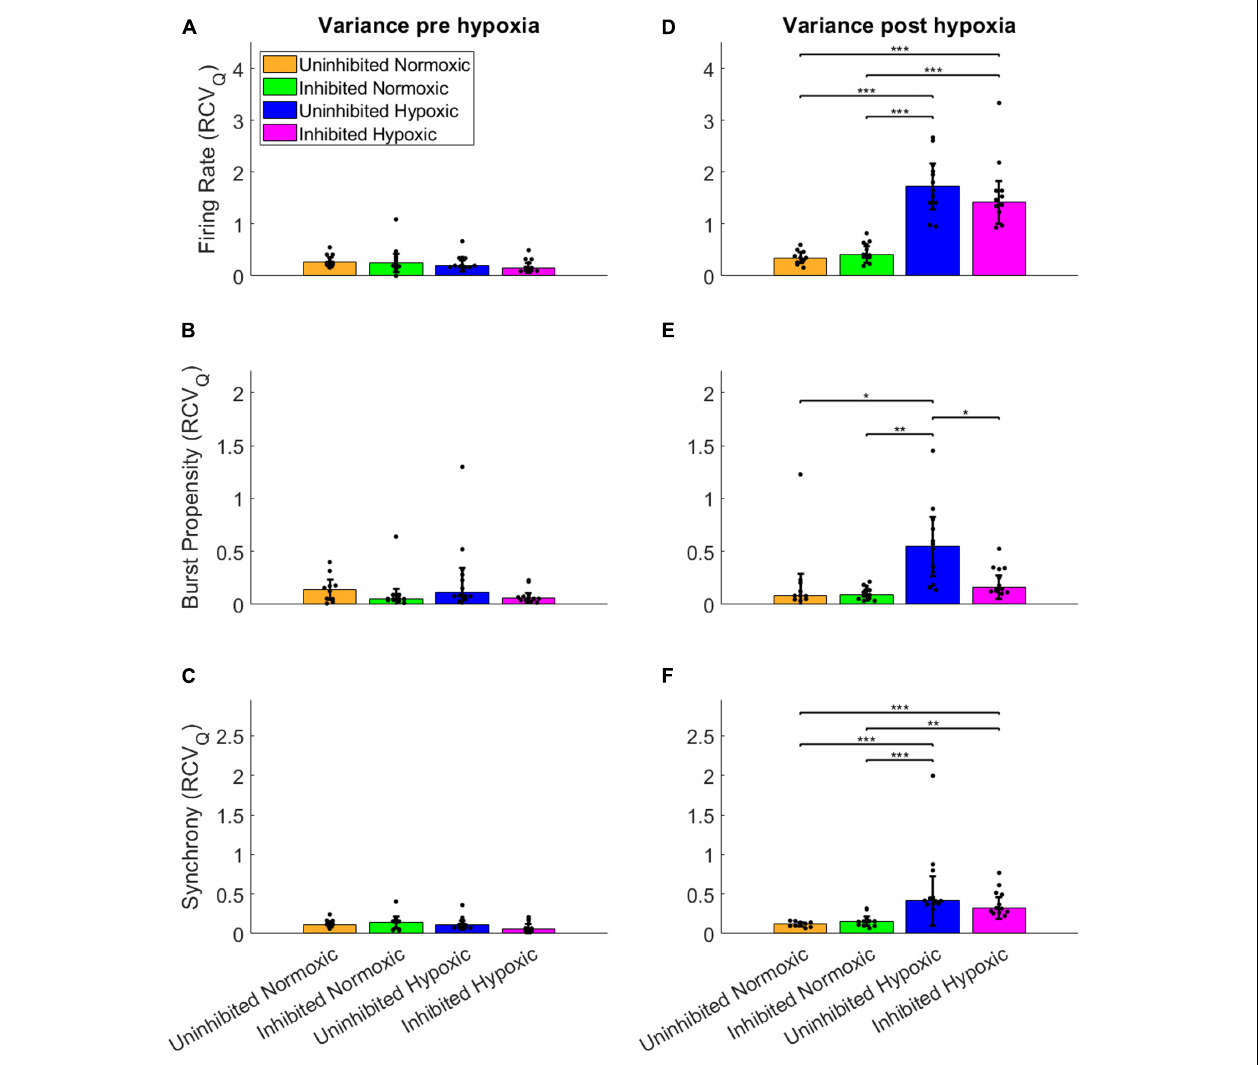
FIGURE 4 | Dispersion in network activity pre and post the hypoxic challenge. The dispersion of the electrophysiology parameters was assessed by the RCV Q of the activity of each network and compared by Wilcoxon rank sum test, prior to and following the hypoxic challenge. The longitudinal dispersion pre-hypoxia showed no significant differences in terms of firing rate (A) , bursting propensity (B) , or synchrony (C) . Post-hypoxia the hypoxic networks showed similar significant increases in longitudinal dispersion in terms of firing rate (D) and synchrony (F) . However, only the uninhibited hypoxic networks showed a significant increase in the dispersion of bursting propensity, while the inhibited hypoxic networks showed significantly less longitudinal dispersion, in line with control networks (E) . * p < 0.0083, ** p < 0.0017, *** p < 0.00017. Bars and error bars indicate median ± median absolute